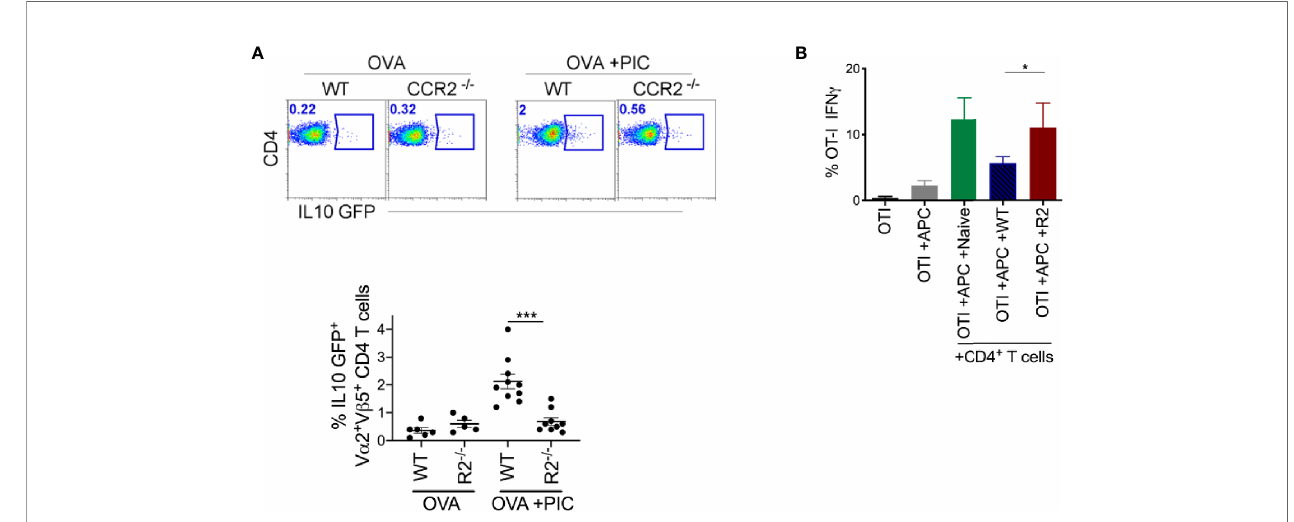
FIGURE 4 | Monocytes are required for the induction of suppressive CD4 + T cells. (A) After immunization as outlined in Figure 1B and adoptive transfer of OTII IL- 10 GFP + cells, LLN antigen-speci fi c OTII IL-10 GFP + T cells was examined in WT and CCR2 -/- mice. Representative fl ow plots display OTII population gated on V a 2 + V b 5 + CD4 + IL-10 GFP + from WT and CCR2 -/- mice, top. Scatter plot analysis of targeted population frequency from individual mice, Bottom. Combined set of 2 independent experiment. (B) WT splenic DCs and CFSE-labeled OTI cells were co-cultured with CD4 + T cells isolated from LLN of either naïve mice or WT and CCR2 -/- mice immunized with OVA ± Poly IC as outlined in Figure 1B . Bar graph demonstrates IFN g (left) and TNF a (right) producing OTI T cells after 5 days of co- culture. Data are representative of two independent experiments, n=4 mice per group. Data are shown as mean ± SEM. ***P value < 0.001. *P < 0.05.